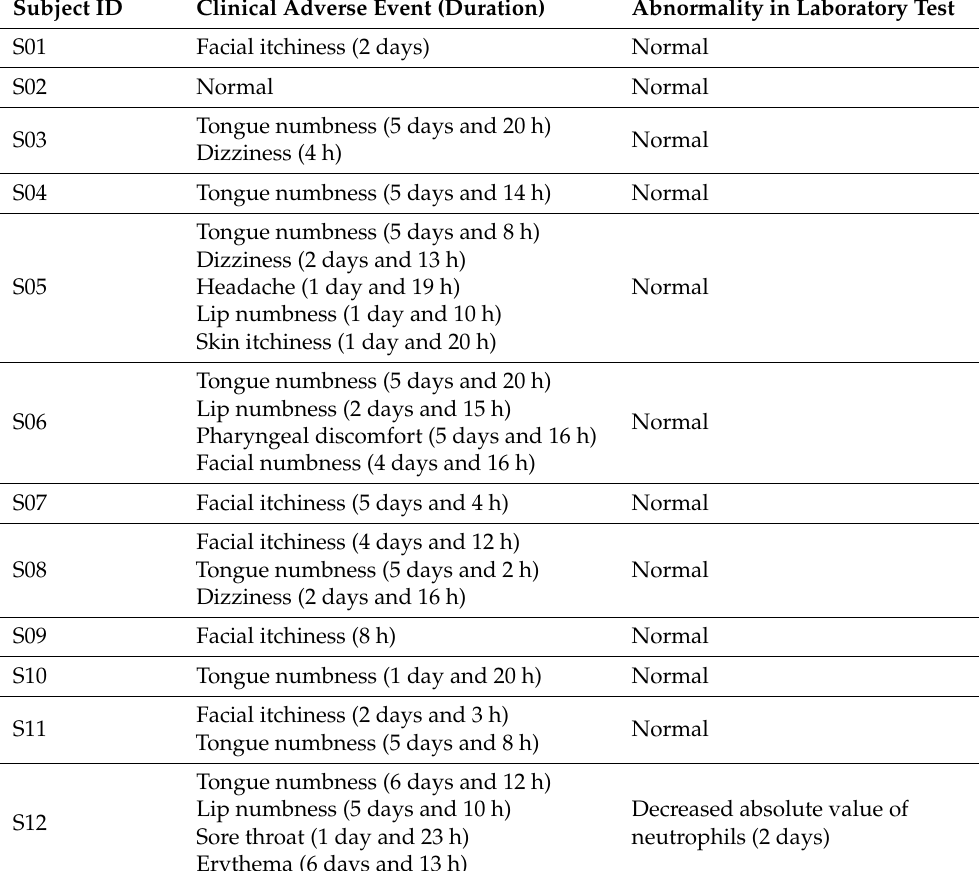
Table 4. List of individual adverse events related to the test drug